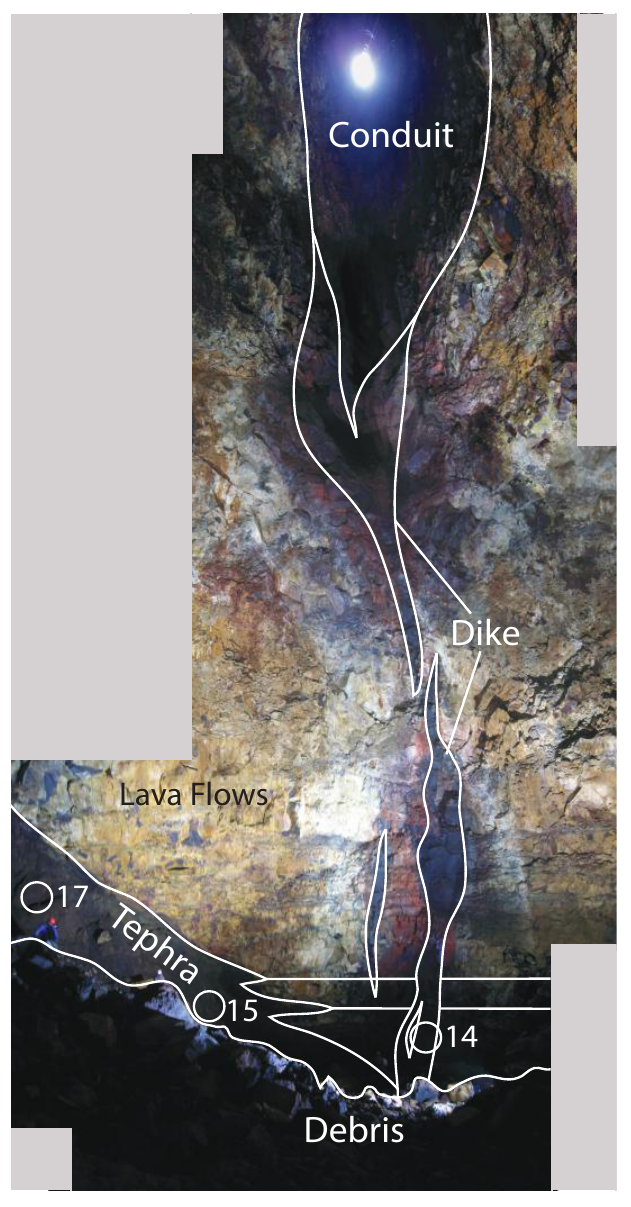
Figure 4: An annotated photo mosaic of the north-northeast cave wall photo mosaic shows the dike cutting through lavas from the base of the cave to the more cylindrical conduit and the surface vent. Additional sample locations are shown with white circles. The unannotated photo (Figure S1) can be found in the Data Repository [Hudak et al.